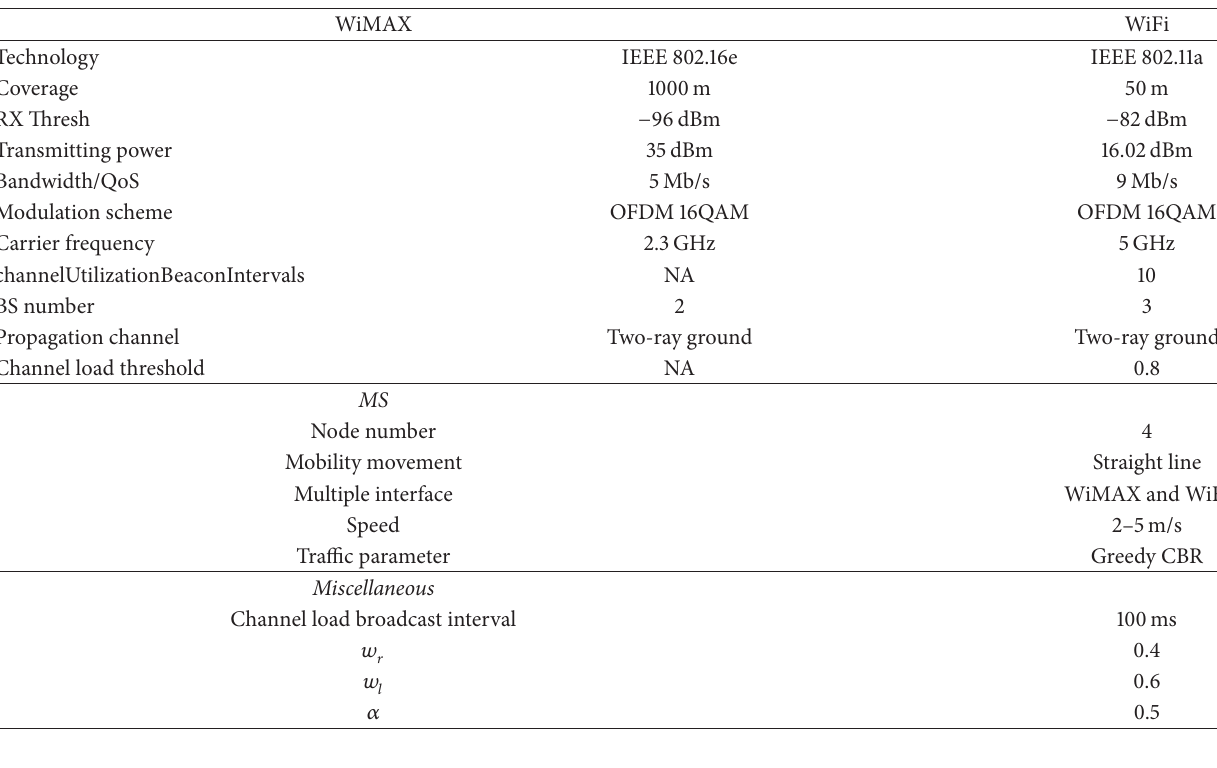
Table 1: Simulation parameter.